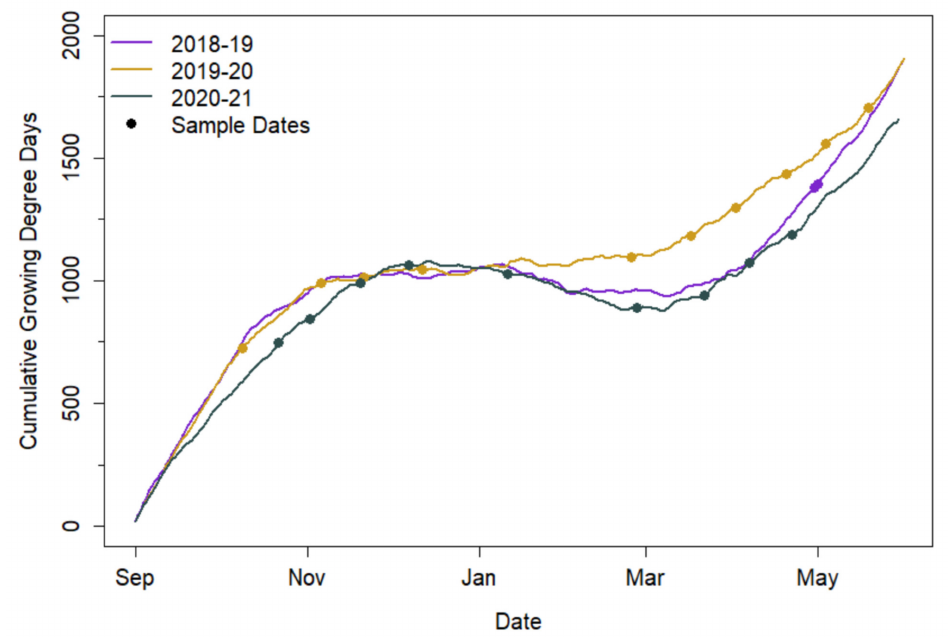
Figure 2. Accumulated growing degree days (GDD, including negative values) for study years (2018–2021) with sample dates (points).